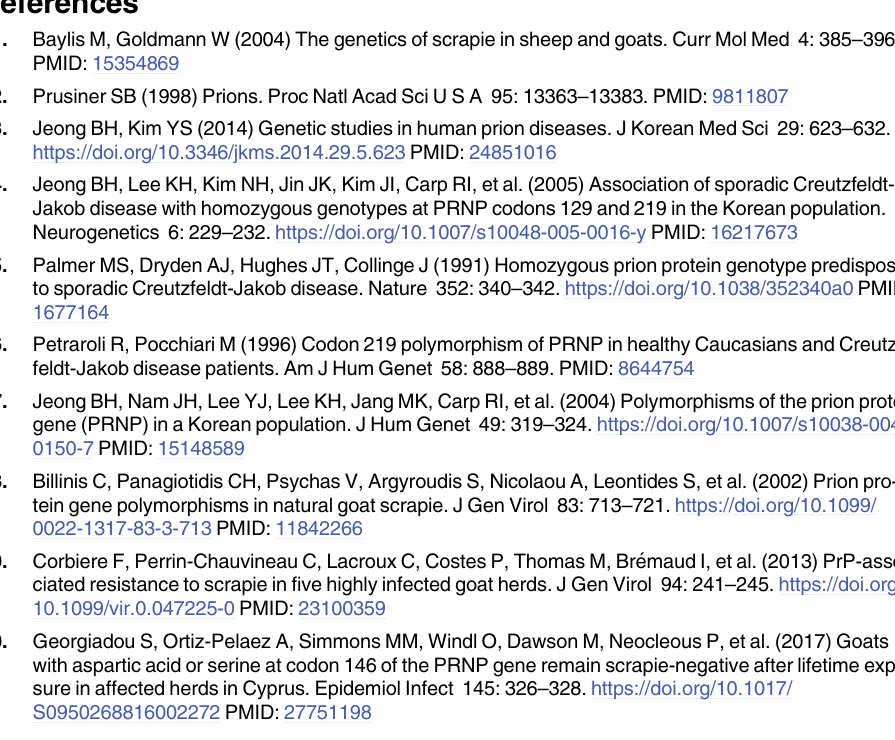
S1 Table. Linkage disequilibrium (LD) between PRNP and PRND SNPs with r 2 values in Korean native black goats. S2 Table. Linkage disequilibrium (LD) between PRND and PRNT SNPs with r 2 values in Korean native black